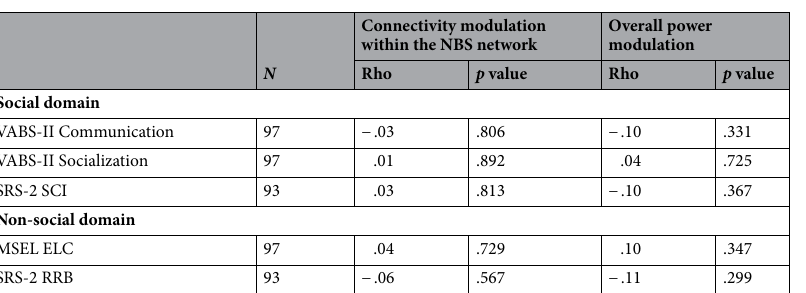
Table 2. Spearman’s correlations between modulations of connectivity and power with later behaviours at the 36-month-old visit. Significant comparisons (at the α level = .05) are printed in bold. MSEL ELC—Mullen Scale for Early Learning Early Learning Composite Standard Score; SRS-2 RRB—Social Responsiveness Scale- 2, T-score for the Restricted and Repetitive Behaviours domain; SRS-2 SCI—Social Responsiveness Scale-2, T-score for the Social Communication and Interaction domain; VABS-II Communication—Vineland Adaptive Behaviour Scale-II, Communication domain standard score; and VABS-II Socialization—Vineland Adaptive Behaviour Scale-II, Socialization domain standard score.